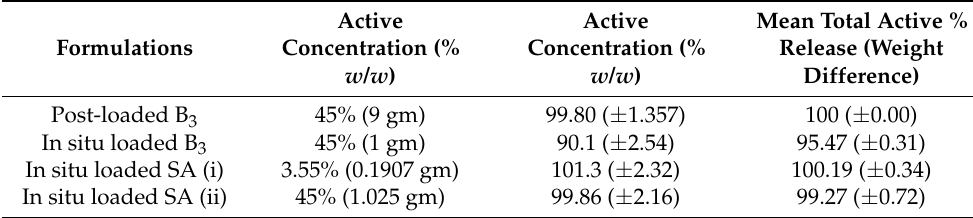
Figure 1. Actives B ₃ and SA release profile (percentage release over time in minutes). Table 3. Release data of all formulations.